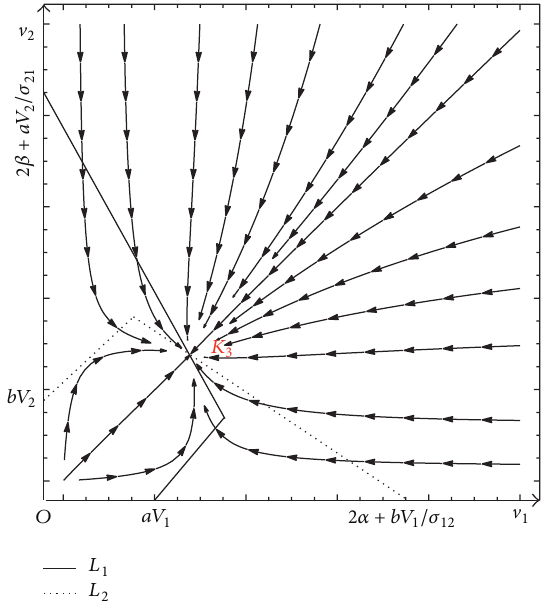
Figure 7: The unique positive equilibrium 𝐾 3